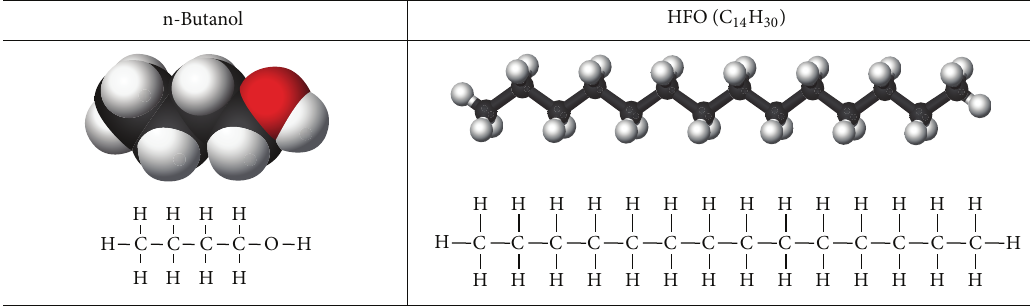
Figure 2: Molecular structure and sketch map of n-butanol compared with C 14 H 30 as a heavy fuel oil.